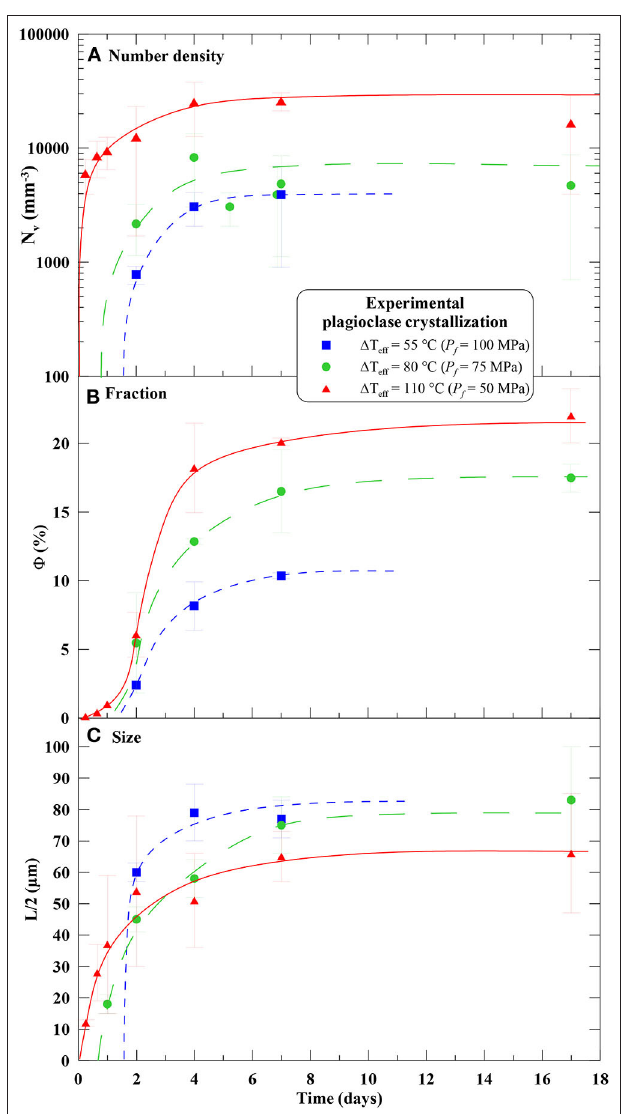
FIGURE 1 | Experimental data of Mollard et al. (2012) showing the time-evolution of the plagioclase crystal (A) volume number density calculated after Higgins (2000) as in Table 2 ; (B) plagioclase proportion, and (C) average of the ten longest semi-axes of the crystals as defined in Mollard et al. (2012). Temperature was 875 ◦ C, initial pressure was 200 MPa, and final pressures were 100, 75, and 50 MPa, corresponding to 1 T eff of 55, 80, and 110 ◦ C, respectively. Note that the curves start at different times, corresponding to an increasing delay in plagioclase nucleation with decreasing 1 T eff . However, for growth modeling, 0 time corresponds to the onset of nucleation.